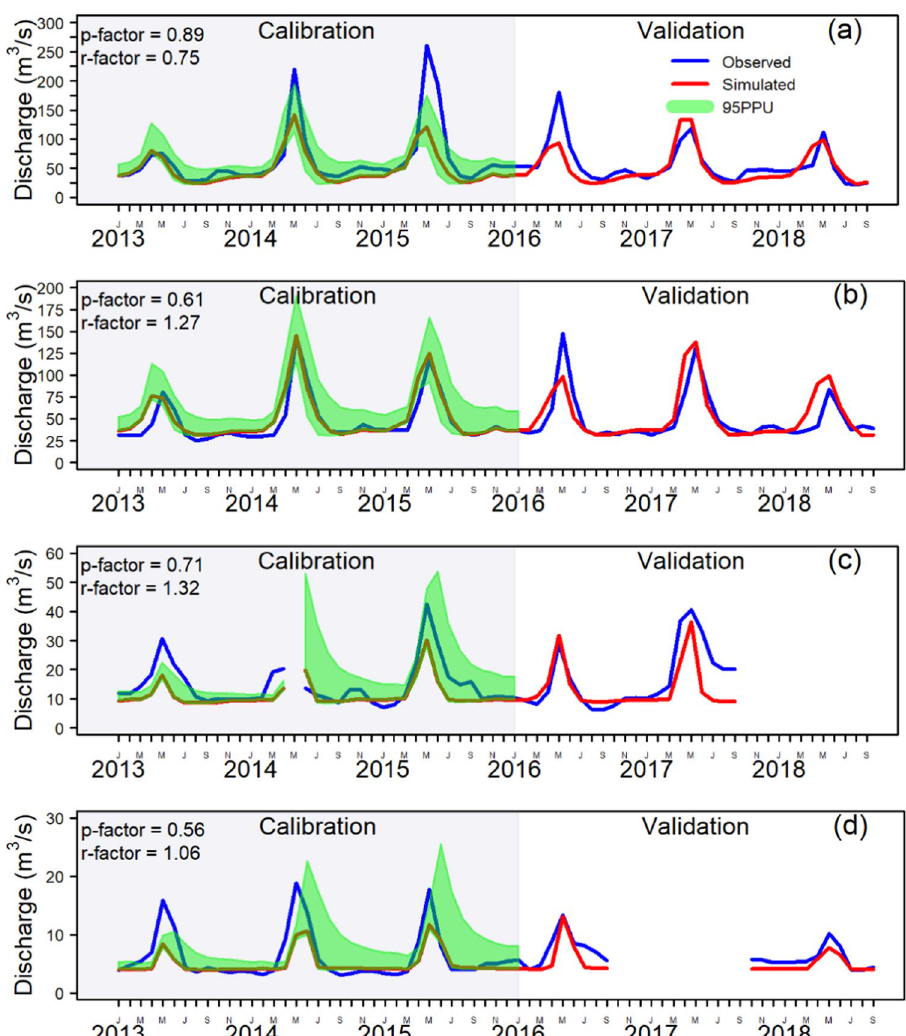
Fig. 3 Comparisons between the observed and simulated monthly discharge in a